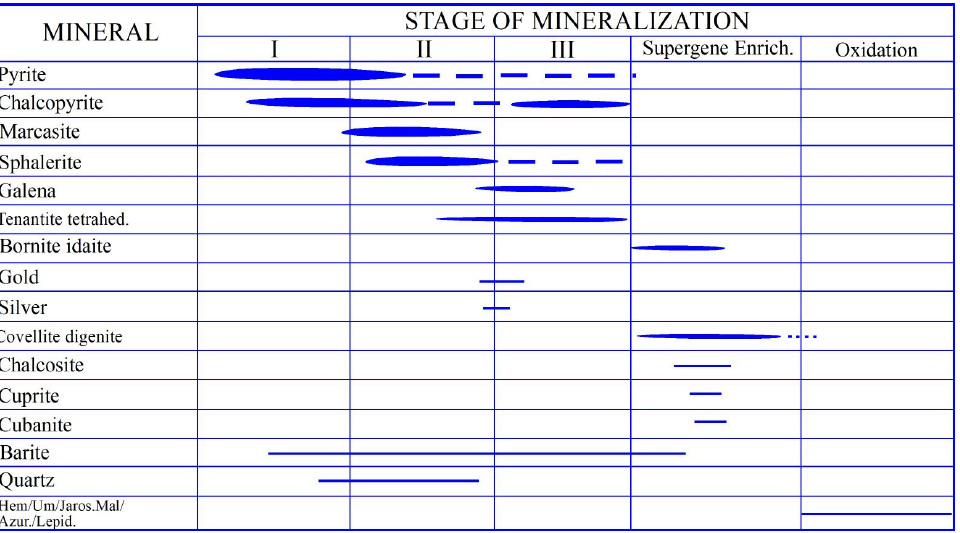
Figure 6. Cerattepe Cu-Au (±Zn) Mineral paragenesis after [41].